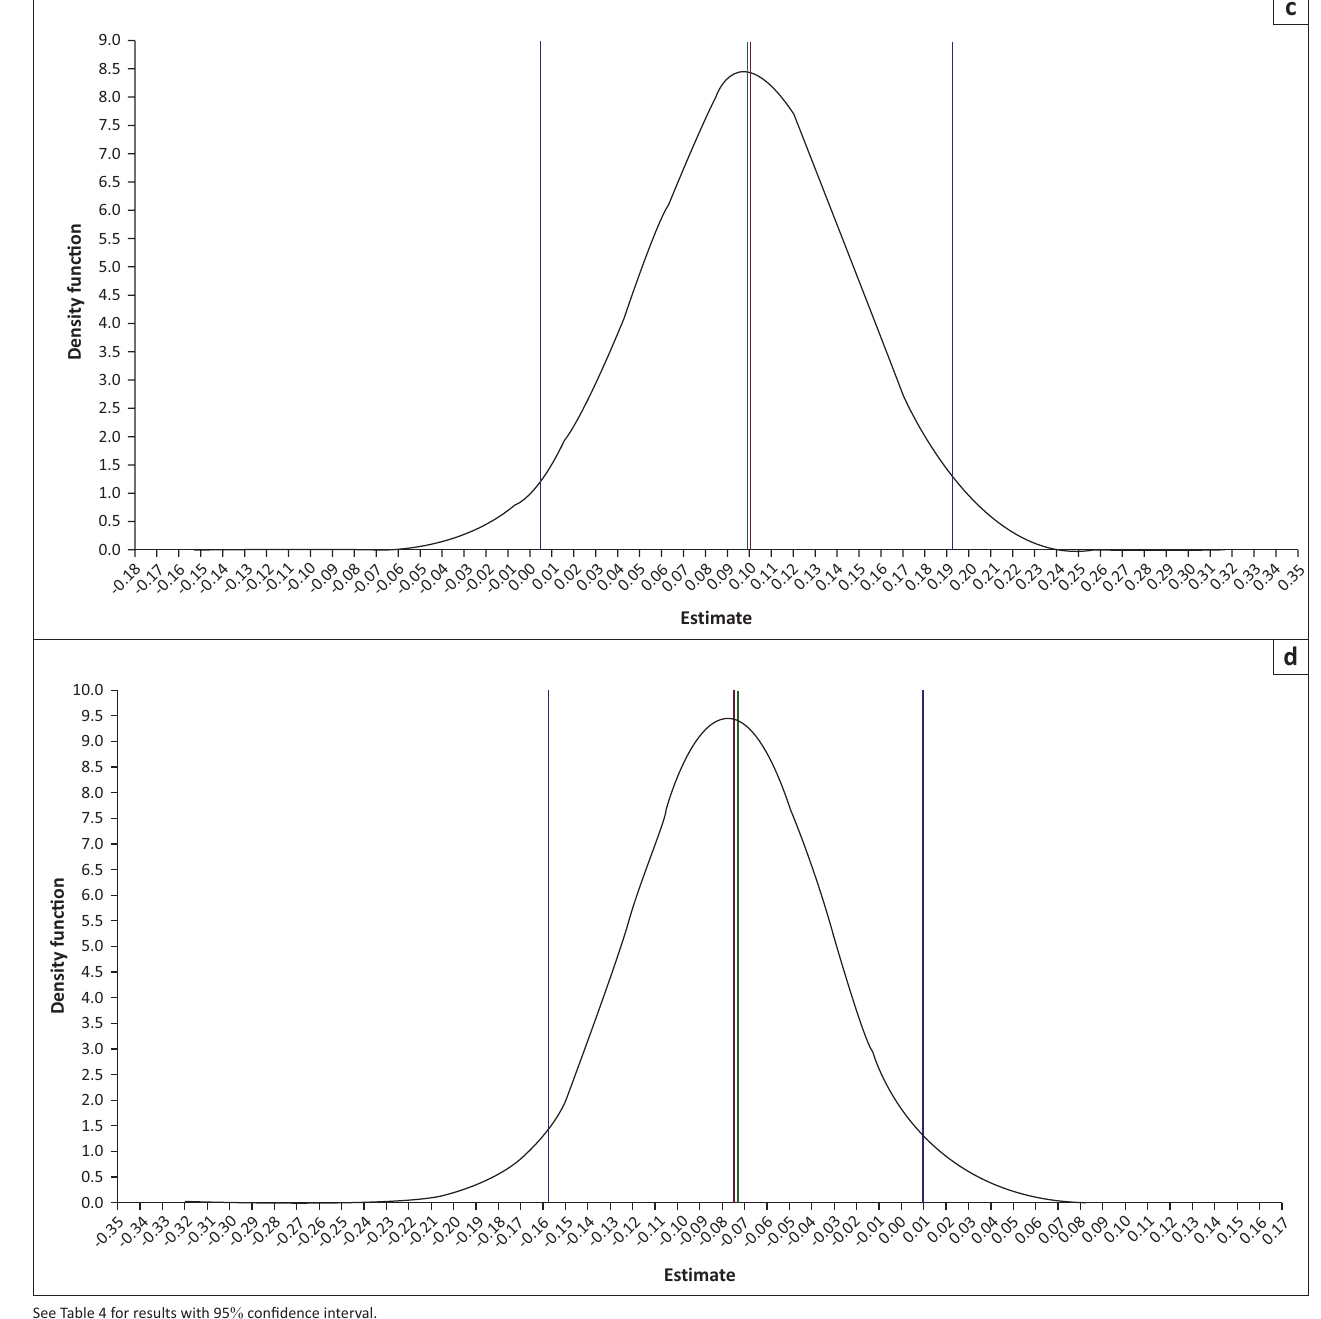
FIGURE 1 (Continues...): Plots for chain convergence and parameter distributions. Parameters: (a) Perceived organisational support for deficit correction (T1) predicting engagement (T2) and (b) perceived organisational support for strengths use (T1) predicting engagement (T2). Kernel density plots: (c) Perceived organisational support for deficit correction (T1) predicting engagement (T2) and (d) perceived organisational support for strengths use (T1) predicting engagement (T2).